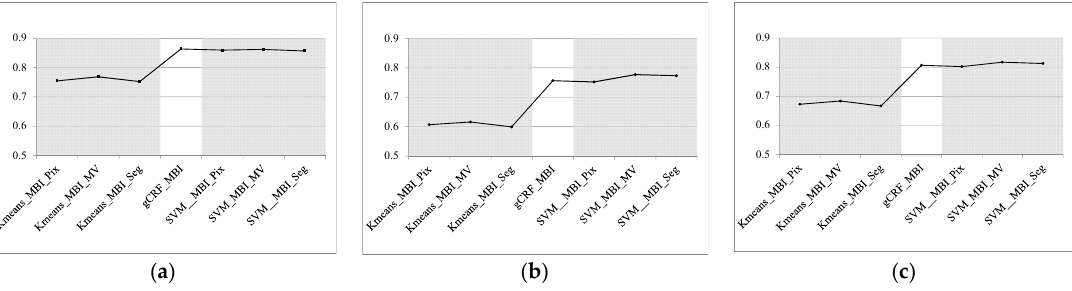
Figure 18. Quantitative evaluation of the MBI-based methods using the QuickBird image: ( a ) recall; ( b ) precision; and ( c ) F -value.